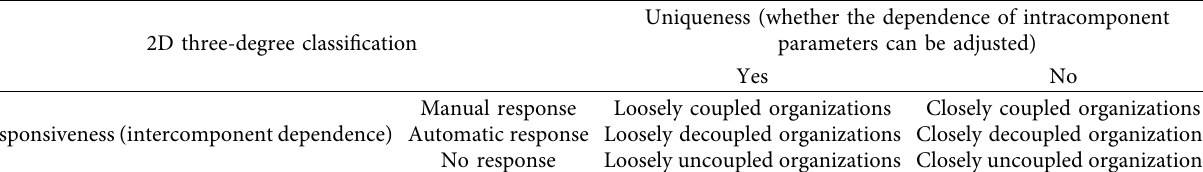
Table 2: 2D three-degree classification of organization coupling.